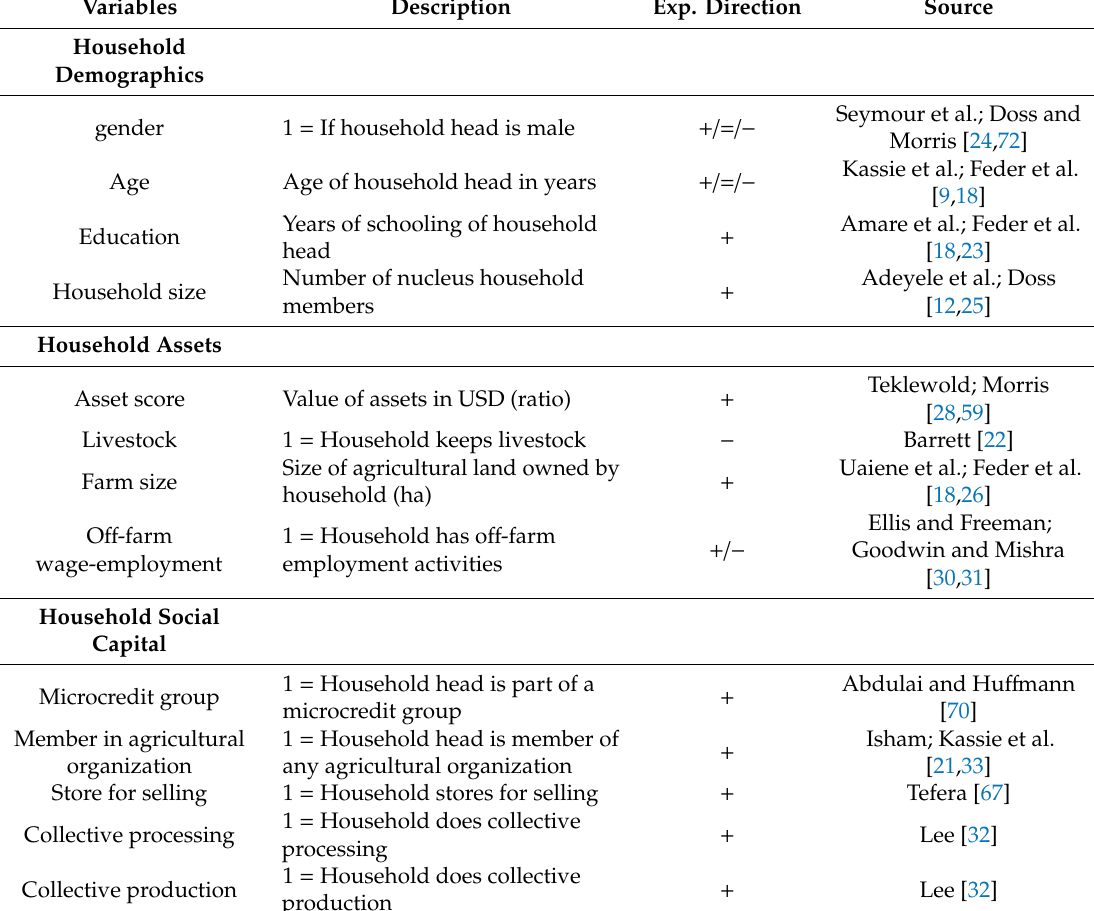
Table A2. Summary of variables used in this study based on